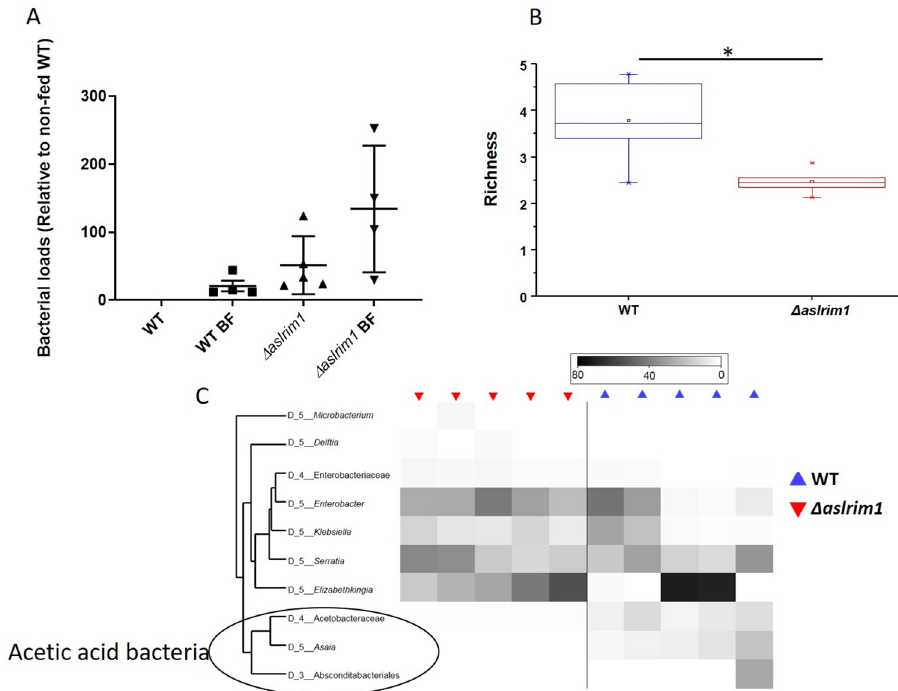
Fig 1. Effect of LRIM1 deletion on the mosquito microflora. (A) Real-time PCR quantification of the bacterial population densities in the mosquitoes. The reaction used 16S rDNA primers, 515F and 806R (Primers 13 and 14, S6 Table), targeting the bacterial V4 region of the SSU rDNA [64]. The PCR was done on DNA from pools of 10 females from each mosquito line (WT and Δ aslrim1 ) before and after blood feeding. The results represent the mean ± SD of 5 replicates for Δ aslrim1 and 4 for the other samples. Mosquito ribosomal protein gene S7 was used as housekeeping gene. (B) Alpha diversity richness analysis (to genus) in WT and Δ aslrim1 indicating higher microbial richness in WT relative Δ aslrim1 (Mann-Whitney U, P = 0.047). (C) Heatmap of the 10 most abundant microbial taxa across mosquito lines. Depth of sequencing ranged from 12827 to 65,296 sequences/sample (Mean = 38,682; median =